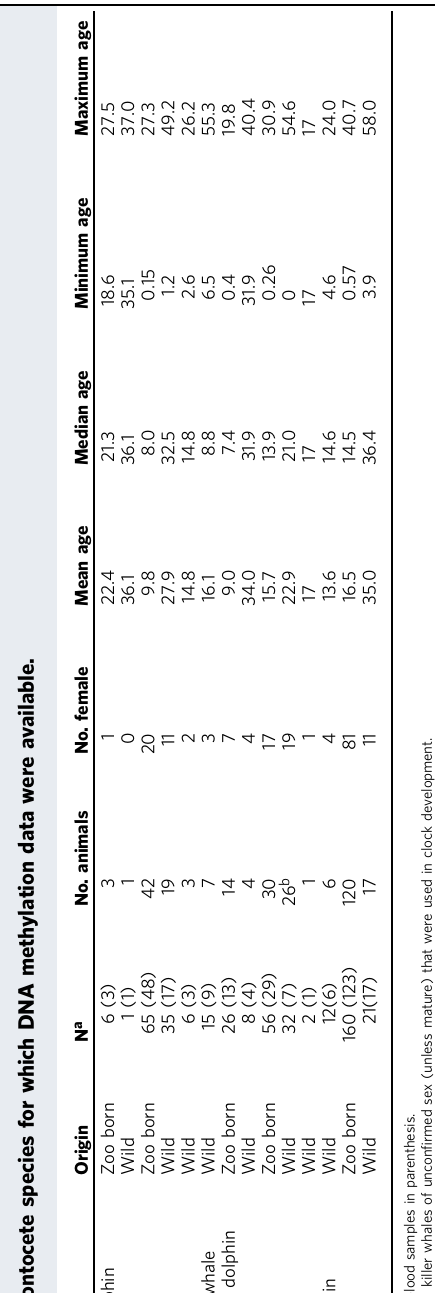
measures: the age correlation r (de fi ned as Pearson moment correlation between the age estimate, DNAm age, and chron- ological age), as well as the median absolute error (MAE, in units of years). The three odontocete clocks were highly accurate based on LOOCV (blood and skin clock: r = 0.94; MAE = 2.57 years [Fig. 1a]; blood clock: r = 0.96; MAE = 2.04 years [Fig. 1b]; skin clock: r = 0.9; MAE = 2.95 years [Fig. 1c]). In addition, the high accuracy according to LOSOCV results from blood and skin clock (median r = 0.94, median MAE = 4.21 years [Supplementary Fig. 2a]); blood clock (median r = 0.94, median MAE = 3.34 years [Supplementary Fig. 2b]) and skin clock (median r = 0.9, median MAE = 7.76 years [Supplementary Fig. 2c]) indicate that these clocks are applicable to any odontocete species that were not part of the original training set. The application of the Odontocete Epigenetic Aging Clock (OEAC) clock toward samples from individuals within each species included in the training set indicated unbiased (LOOCV) age estimations of high accuracy for each species. Estimates from blood samples had correlations that ranged from r = 0.95 (MAE = 1.5 years) for bottlenose dolphins (Fig. 2a) to r = 0.98 (MAE = 2.6 years) for Paci fi c white-sided dolphin (Fig. 2g). Correlations for skin samples ranged from r = 0.89 (MAE 3.2) for killer whales (Fig. 2f) to r = 0.97 (MAE = 1.7 years) for the Paci fi c white-sided dolphin (Fig. 2h). Estimates from low frequency species, species with ≤ 15 samples in total (Table 1), were combined for illustration purposes resulting in a correlation of r = 0.85 (MAE = 2.8 years, Fig. 2i). Across the predictions, whereby species had both blood and skin samples, blood samples had a median 3.2% improvement in accuracy and a 1.31 year decrease in MAE. Age prediction versus GLG layers in beluga teeth . Ages of two beluga were predicted from blood samples of known age (KA) or estimated age (EA, allometric estimation of juvenile at collection) within this study. GLG layers in teeth from these animals had previously GLG been counted 22 . The known age or EA of the beluga, and unbiased DNAm predicted age and GLG counts were as follows: Animal 1, EA = 29.25 y, DNAm age = 32.4 y and 33.0 (from two samples), GLGs = 55 – 60 + ; Animal 2: KA = 21.3 y, DNAm age = 17.8 y, GLGs = 40 – 42. Epigenetic estimator of sex, tissue, and species . We built ran- dom forest predictors for three categorical variables: species; tis- sue type (skin versus blood); and sex across the eight cetacean species. In other words, we ignored species when fi tting the random forest predictors. The random forest predictor for species led to nearly perfect accuracy with the out-of-bag (OOB) estimate of the error at 1.5%. The error arose from species with low tissue counts ( N = 2 for harbor porpoise, N = 4 for common dolphin). The random forest predictor of blood versus skin was perfectly accurate (OOB error = 0%). The random forest predictor of sex-associated differences in DNAm across the various odontocete species led to an OOB error of 0.5 percent, i.e., it misclassi fi ed two animals. We identi fi ed four CpGs that are highly differentially methylated across sex (Supplementary Fig. 3). Three CpG probes ( “ cg00878023 ” , “ cg03341064 ” , “ cg152 81901 ” ) assume lower methylation values in male than in